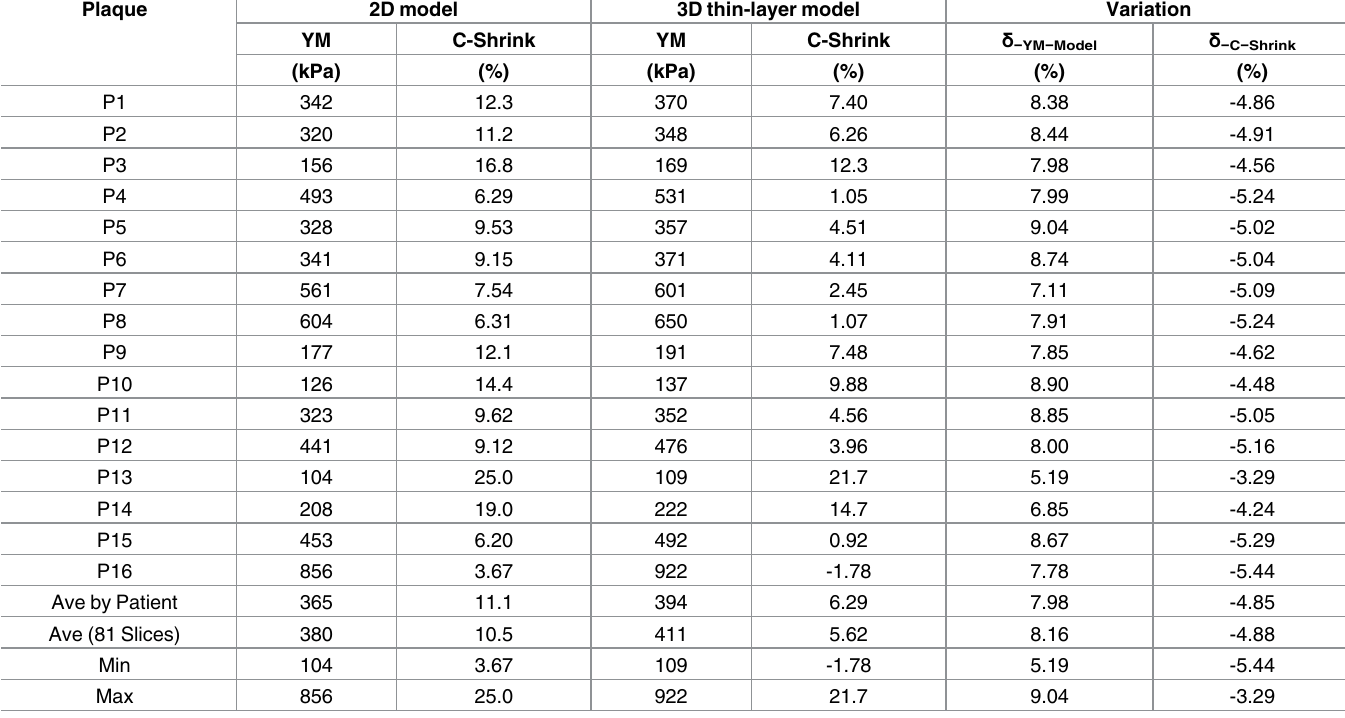
Table 6. The averageeffectiveYoung’s modulus (YM) values and circumferential shrinkage values for 16 carotid plaque samples based on Cine MRI data by using 2D and 3D thin-layer model. Plaque